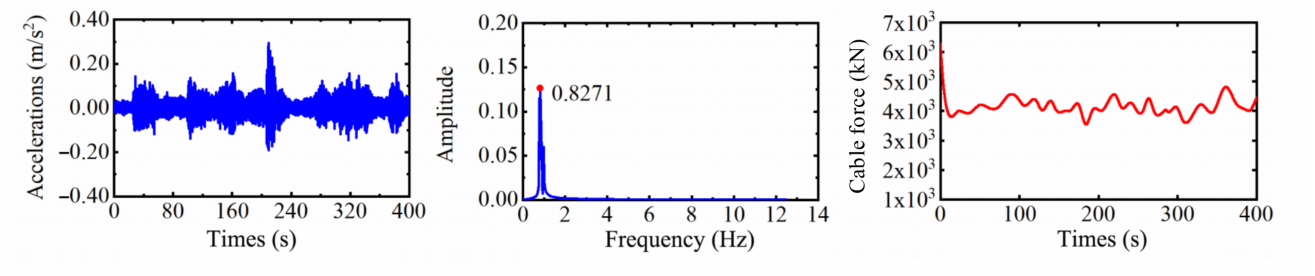
Figure 16. Acceleration signal, vibration spectrum and time-varying force of the A15 cable in the time interval of 16:00–17:00 on 11 October 2019.